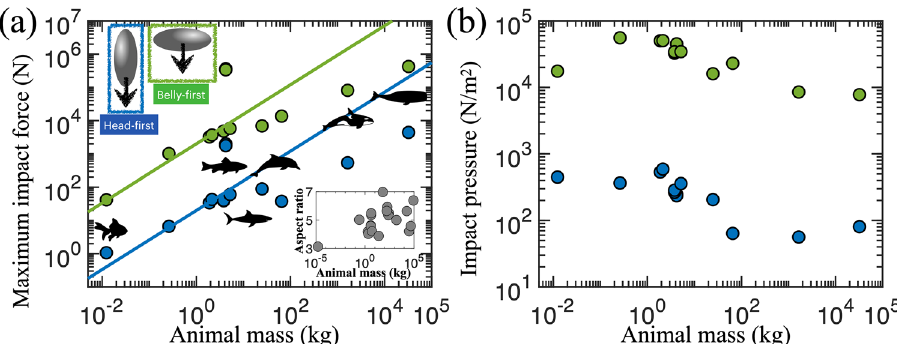
Figure 5. (a) Maximum impact force vs animal mass. Green symbols are belly-first dives and blue symbols are head-first dives. The maximum impact force is estimated from Eq. (25) as a function of the body shape and impact speed. The impact speed is evaluated from the jumping height of various aquatic animals ranging from goldfish to whale 11 . The inset shows the body aspect ratio of animals. (b) Impact pressure vs animal mass. The impact pressure does not show a clear trend with